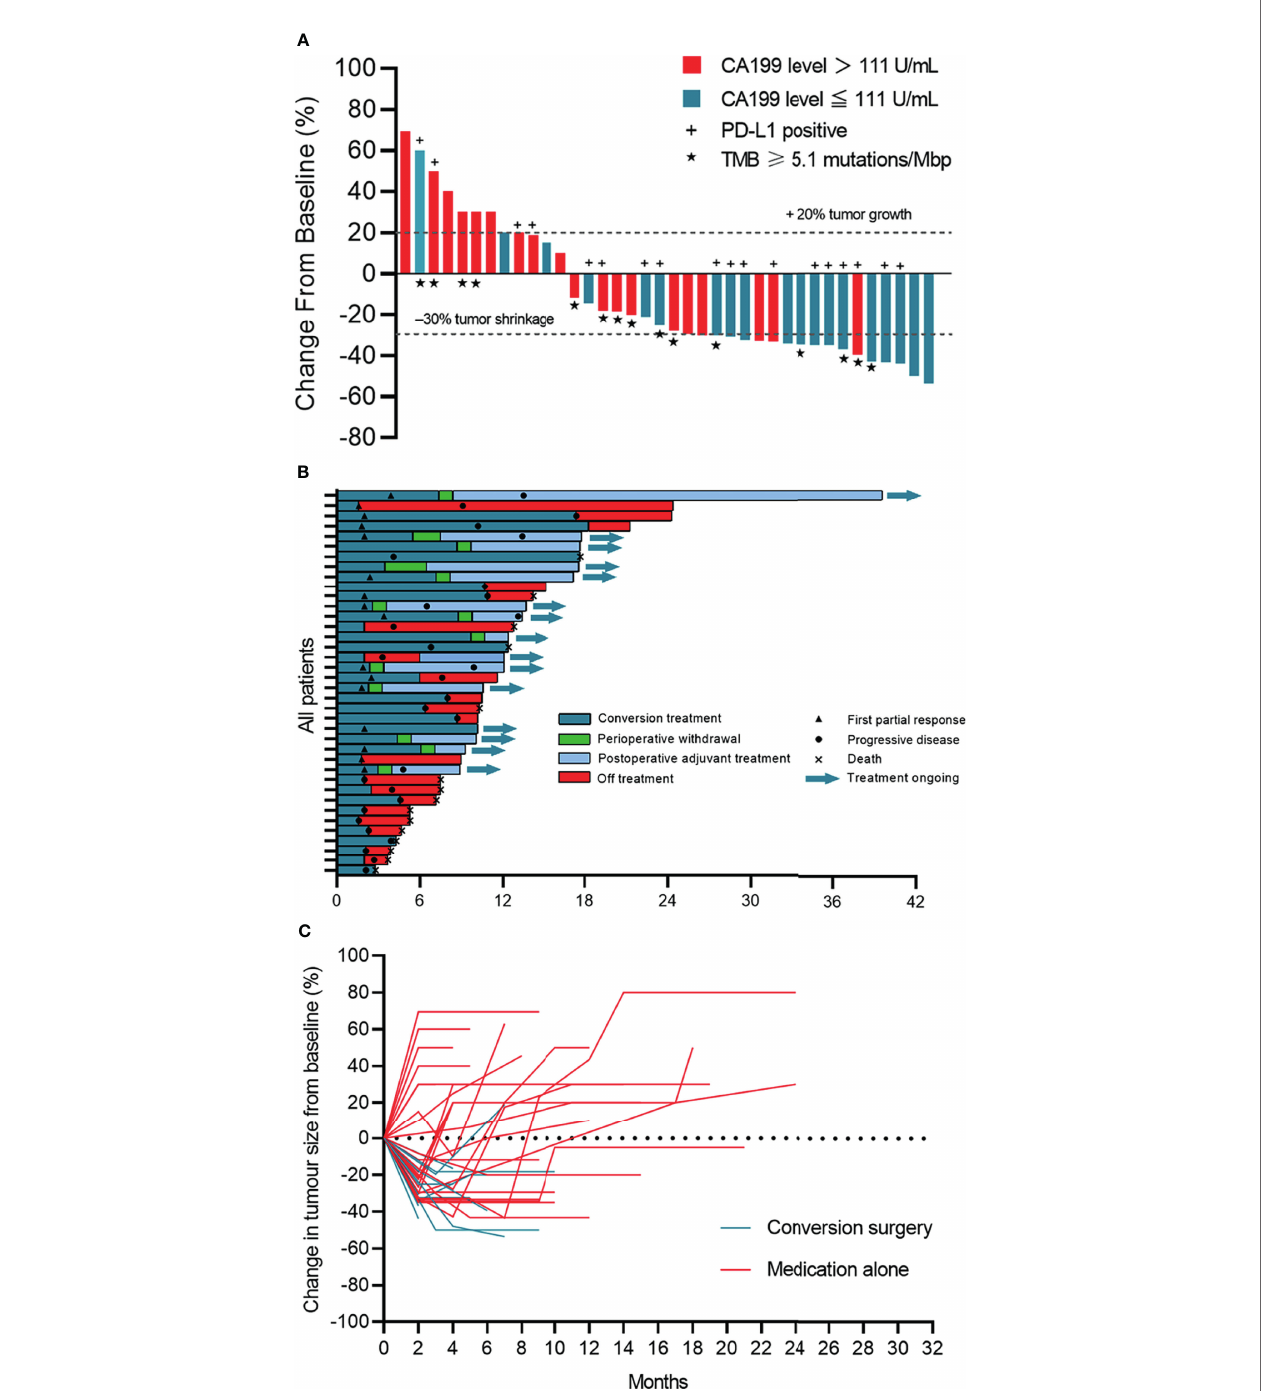
FIGURE 1 | Tumor response. (A) Waterfall plot of maximum percent change in tumor size from baseline in each patient as measured by RECIST (version 1.1). (B) Time on treatment. (C) Longitudinal change in tumor size from baseline. Patients who underwent surgery stopped follow-up after the primary tumor was